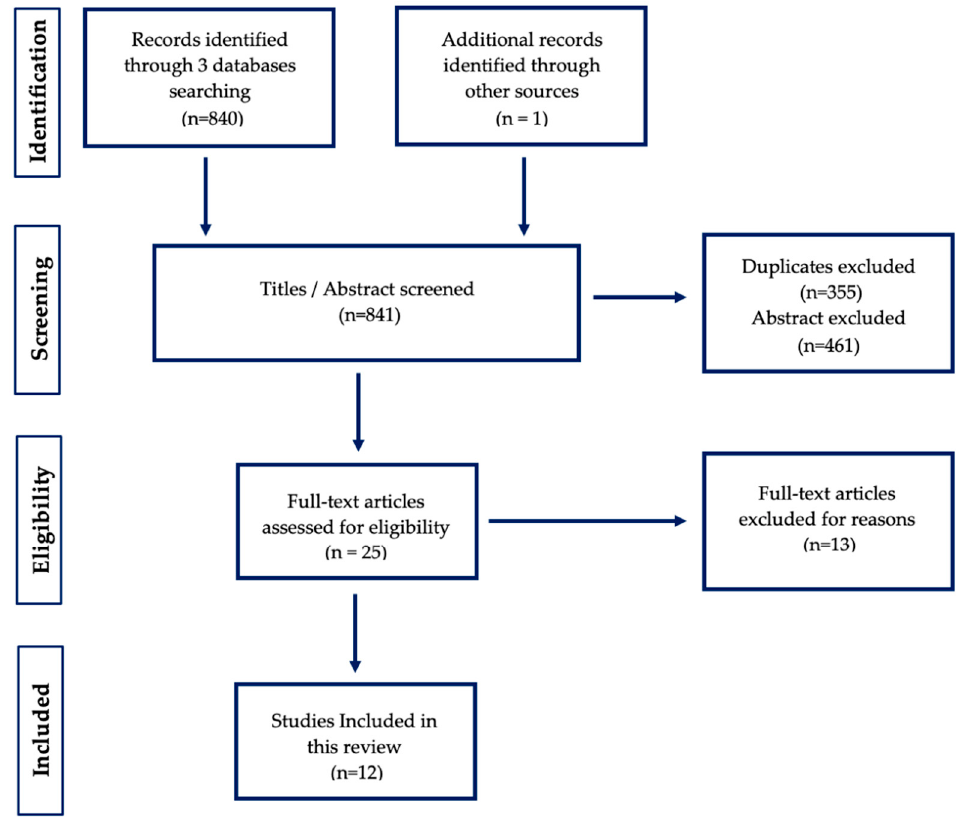
Figure 1. PRISMA diagram for interactive behaviors article search.